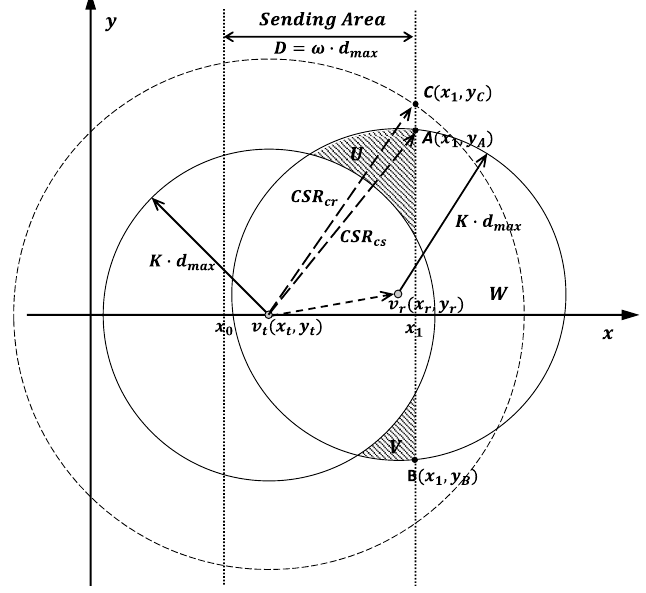
Figure 3. Diagram of interference from concurrent senders in the same